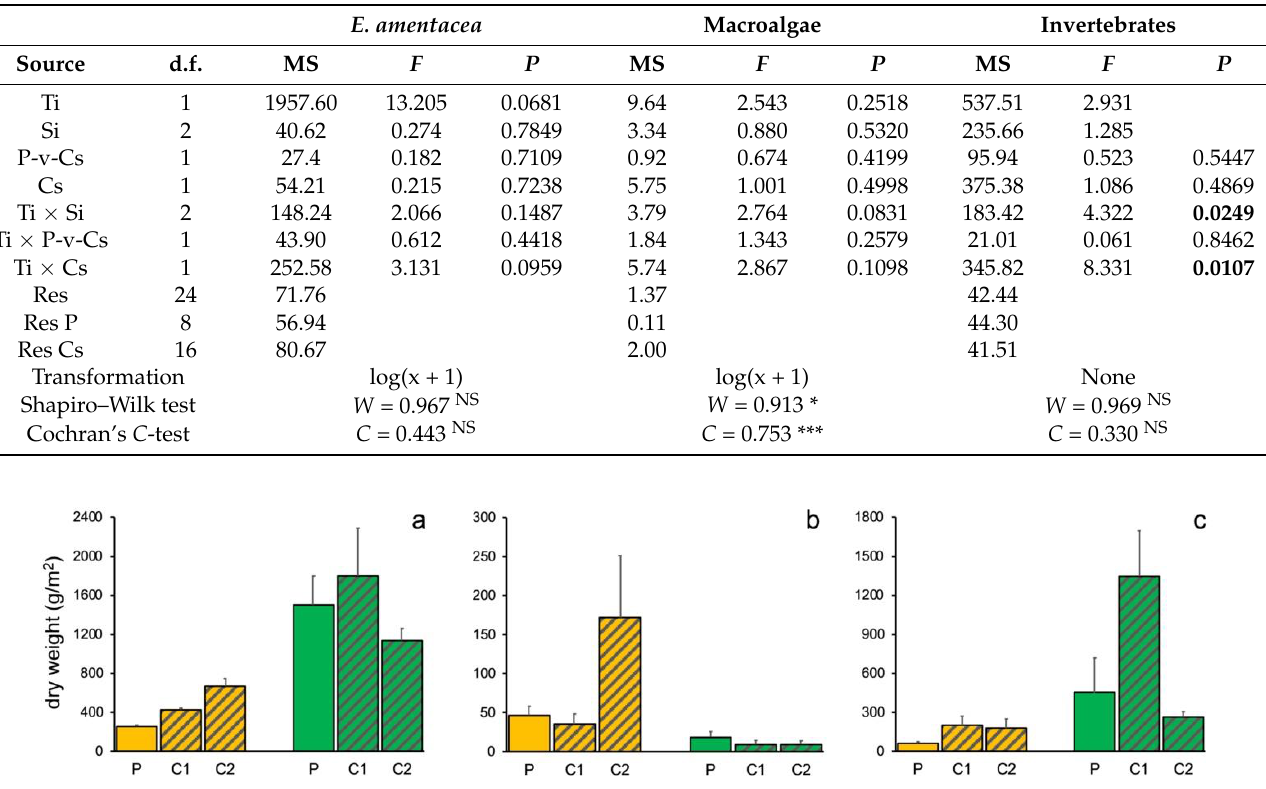
Figure 2. Mean ± SE ( n = 5) total biomass (dry weight) of ( a ) E. amentacea , ( b ) macroalgae, and ( c ) invertebrates at the fully protected site (P) and the two control sites (C1 and C2, dashed bars) of PFN in each sampling time. Time 1 (T1) = orange bars, Time 2 (T2) = green bars. Note that scales on y-axis are different. Table 1. Summary of asymmetrical ANOVA testing for differences between P and Cs in total bio- mass (dry weight) of E. amentacea , associated macroalgae, and invertebrates at PFN. The main effect of terms involved in higher-order interactions were not tested. Results of tests for the assumption